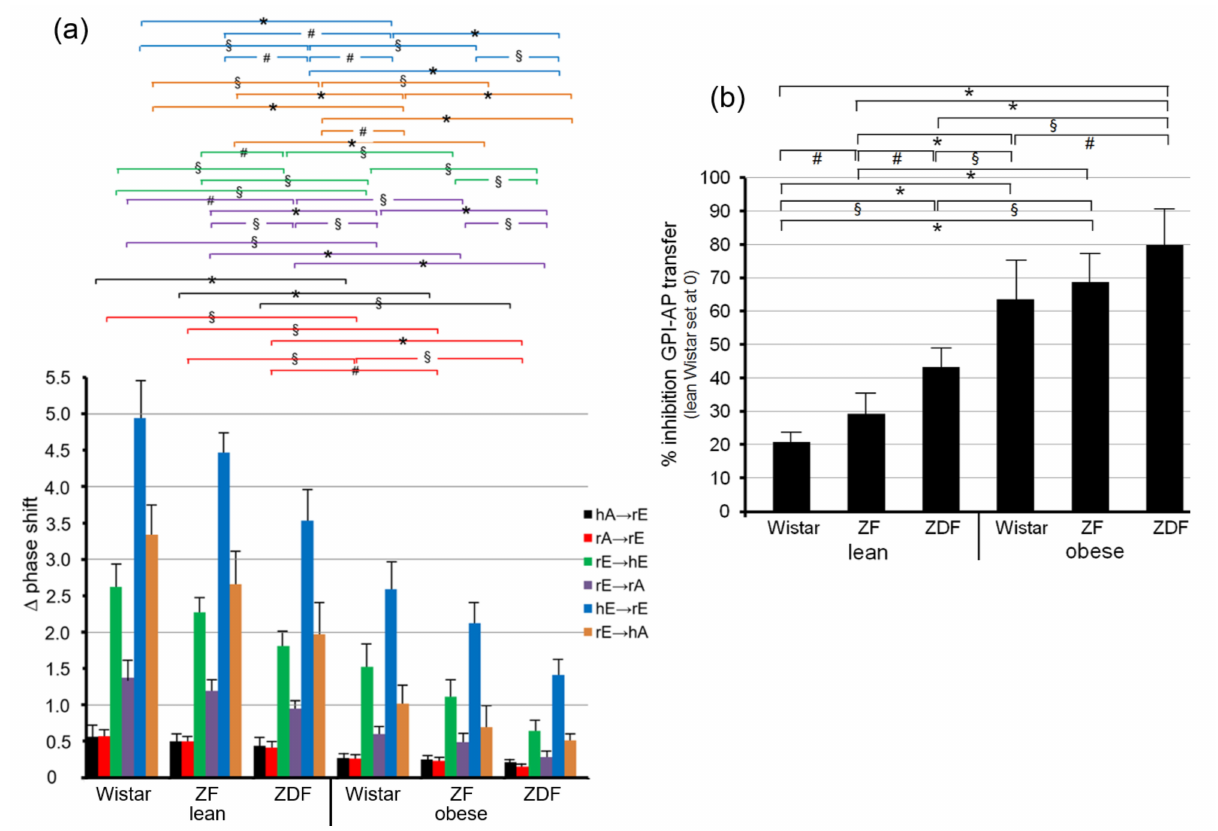
Figure 12. Comparative quantitative evaluation for the six rat groups of the inhibition of transfer of full-length GPI-APs from donor to acceptor PM at the various combinations ( a ) and the calculated means thereof ( b ). The experiment was performed as described for Figure 11 with measurements repeated six times for each donor–acceptor PM combination (different incubations with distinct chips each). ( a ) ∆ phase shifts as measure for GPI-AP-induced increases in phase shift are calculated as described for Figure 7 and given as means ± SD for each combination with statistical significance (* p ≤ 0.01, § p ≤ 0.02, # p ≤ 0.05) indicated only for rat groups displaying relatively small differences (for reasons of clarity). ( b ) % inhibition of GPI-AP transfer was calculated relative to control (-serum, Figure 11) for each of the six donor–acceptor PM combinations and each of the six rat groups upon normalization of lean Wistar rats (set at 0) as means ± SD with statistical significance (* p ≤ 0.01, § p ≤ 0.02, # p ≤ 0.05) indicated between all rat